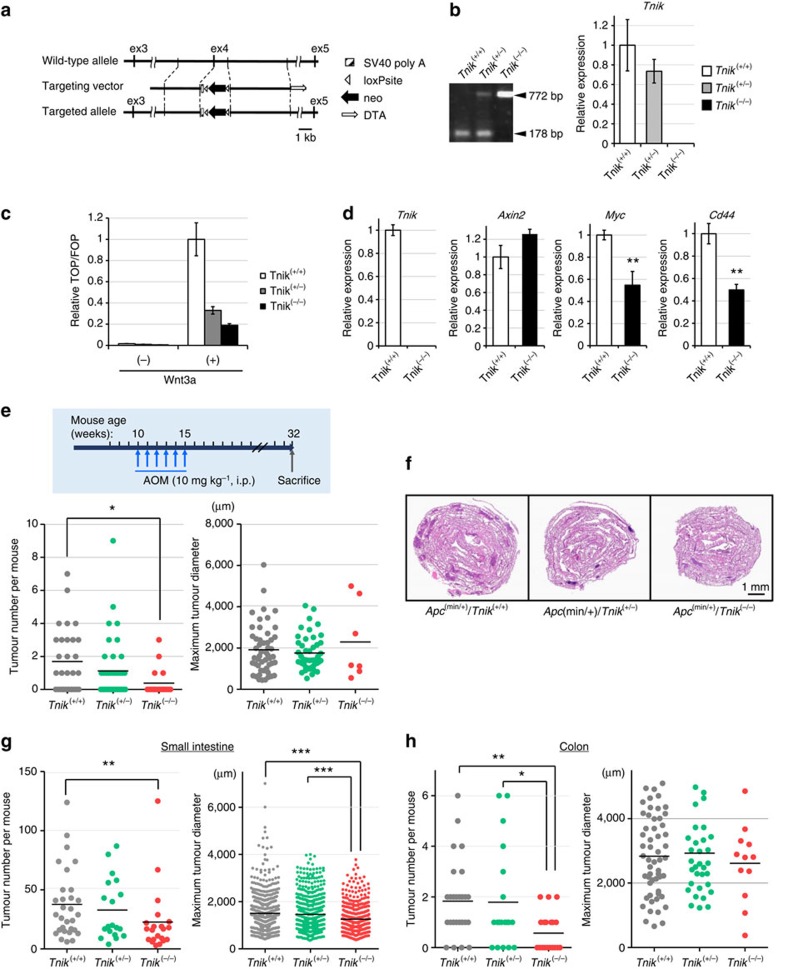
Reduced tumorigenicity of Tnik-deficient mice.(a) Schematic representation of the Tnik allele and the targeting construct with the neomycin (neo) cassette driven by the phosphoglycerate kinase I (PGK) promotor as a positive selection marker and diphtheria toxin (DTA) as a negative selection marker. (b) Representative PCR-based genotyping (left) and relative Tnik gene expression (normalized to β-actin (Actb1)) in the brains of 10-week-old male wild-type (C57BL/6J-Tnik+/+), heterozygous mutant (Tnik+/−), and homozygous mutant (Tnik−/−) mice (right). Error bars represent s.e.m. (c) TCF/LEF transcriptional activity of MEFs derived from Tnik+/+, Tnik+/− and Tnik−/− embryos. MEFs were transfected with the superTOP-flash or superFOP-flash luciferase reporter in triplicate and treated with 30 ng ml−1 recombinant Wnt3a for 24 h or not. (d) Relative expression of Tnik and Wnt target genes (Axin2, Myc and Cd44) by MEFs derived from Tnik+/+ and Tnik−/− embryos. (e) Schedule of AOM treatment (top) and the mean number and maximum diameter of tumours developed in male Tnik+/+ (n=30), Tnik+/− (n=40) and Tnik−/− (n=18) mice at the age of 32 weeks (bottom). *P<0.05. (f) Macroscopic (so-called Swiss roll) view of whole small intestines of representative Apcmin/+/Tnik+/+, Apcmin/+/Tnik+/− and Apcmin/+/Tnik−/− mice. (g,h) Mean numbers and maximum diameters of tumours that developed in the small intestine and colon of 16-week-old male Apcmin/+/Tnik+/+ (n=30), Apcmin/+/Tnik+/− (n=19) and Apcmin/+/Tnik−/− (n=21) mice. ***P<0.001; **P<0.01; *P<0.05.